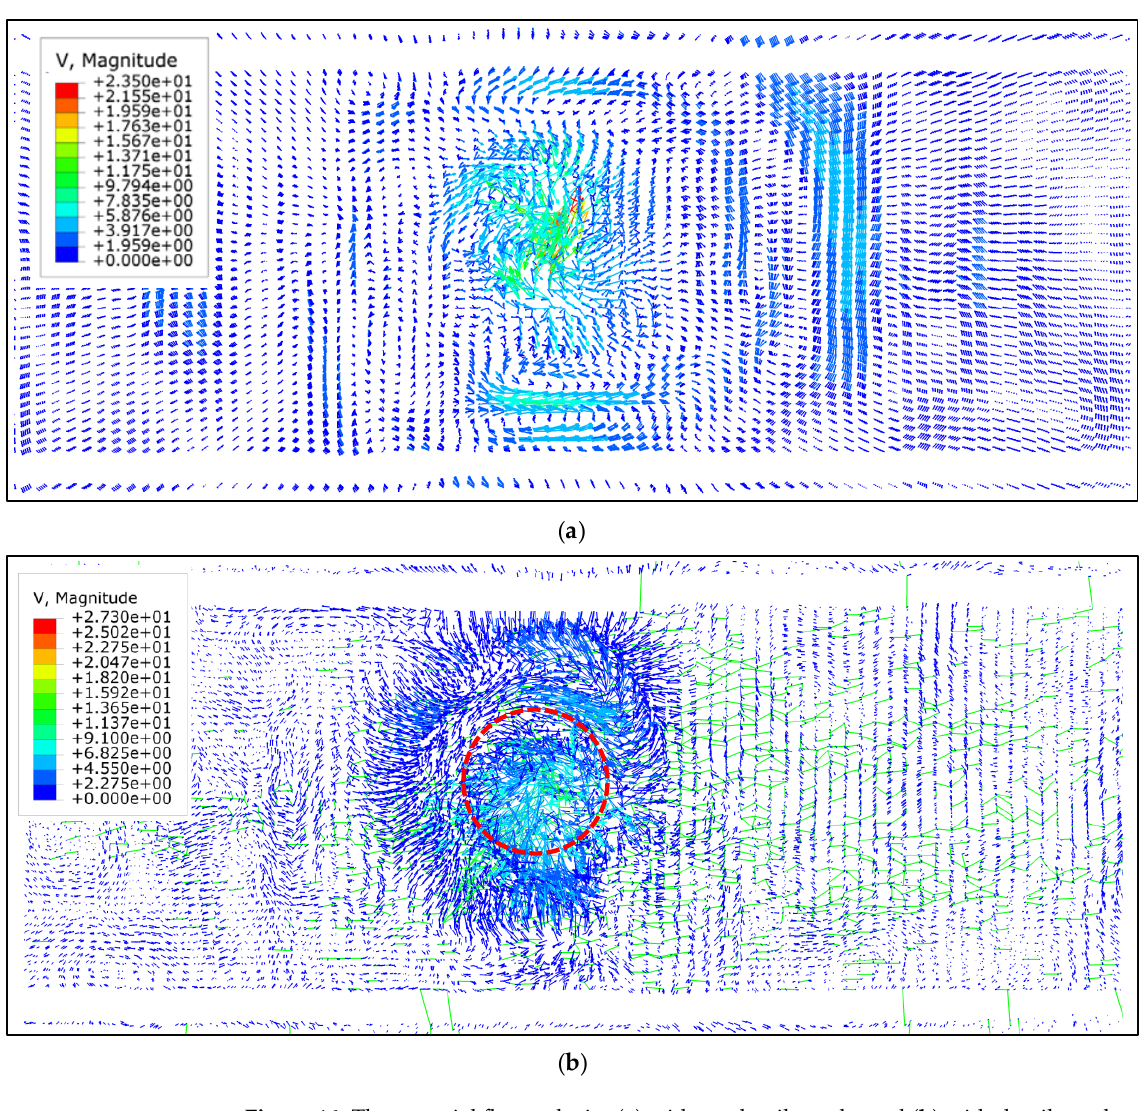
Figure 16. The material flow velocity ( a ) without the tilt angle, and ( b ) with the tilt angle. The maximum value of the material flow velocity for the model with the tilt angle of 1.5 is found to be around 27 (m/s) which is almost equal to 30 percent of the tool